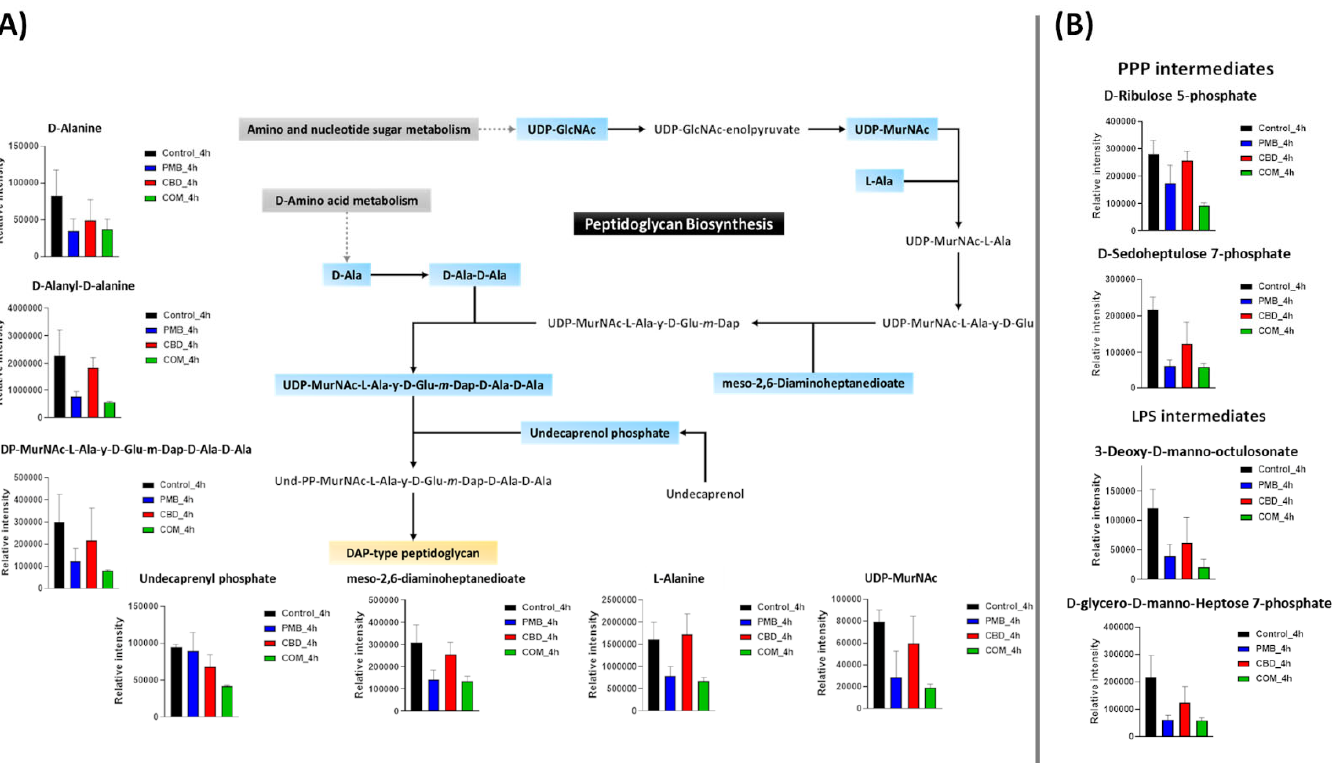
Figure 3. ( A ) Schematic diagram depicting significantly impacted metabolites and bar charts of amino ‐ sugar and nucleotide ‐ sugar metabolism and downstream peptidoglycan biosynthesis for A. baumannii ATCC 19606 treated with polymyxin B (PMB) or cannabidiol (CBD) monotherapy and the combination (COM) after 4 h exposure. ( B ) Bar charts for the significantly impacted metabolites of pentose phosphate pathway (PPP) and lipopolysaccharide (LPS) biosynthesis following polymyxin B (PMB) or cannabidiol (CBD) monotherapy and the combination treatment at 4 h ( ≥ 0.59 ‐ log 2 ‐ fold, p ≤ 0.05). Blue rectangles: significantly inhibited metabolites; Red rectangles: Significantly increased metabolites.